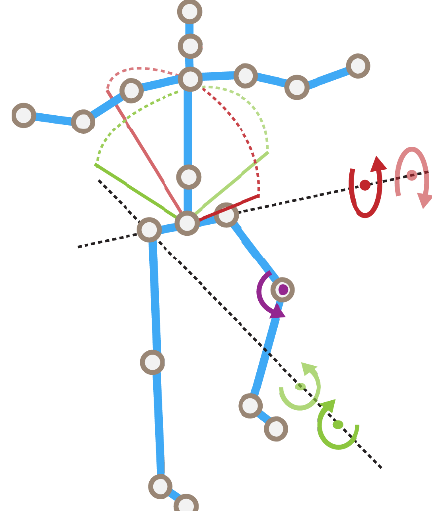
Figure 7 | Participant’s skeleton and the used features (circular arrows).